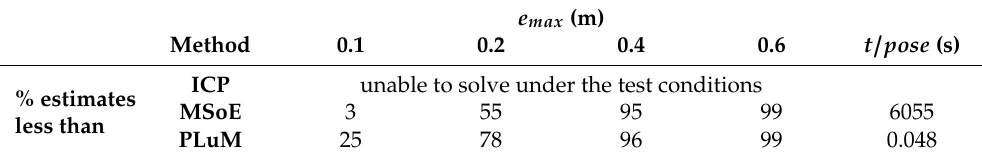
Table 8. The maximum vertex error and execution time in comparison to other